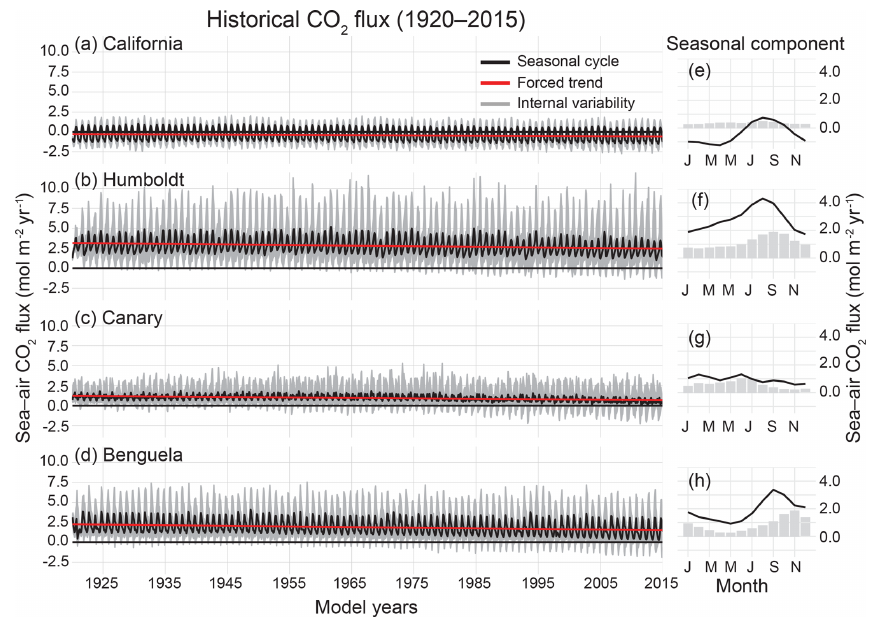
Figure 4. Time series of historical CO 2 flux (1920–2015) in the CESM-LENS for each of the four studied upwelling systems (a–d) . The ensemble mean yields both the seasonal cycle (black) and the forced trend (red). Gray shading shows the bounds of the maximum and minimum realizations due to internal variability, but also contains signal from the seasonal cycle and forced trend. Table 1 displays the intercept, seasonality, internal variability, and forced trend for each system. (e) – (h) show the mean seasonal cycle (black line) and ensemble mean monthly internal variability (gray bars) for 1920–2015 for each